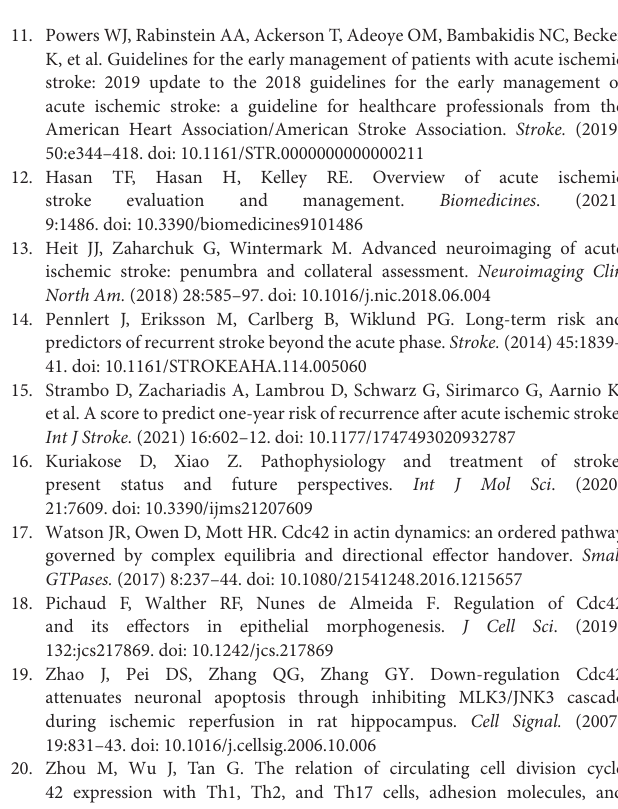
Supplementary Table S1 | Factors related to risk of ischemic stroke by univariate logistic regression model analysis. Supplementary Table S2 | Correlation of CDC42 at admission with underlying diseases in AIS